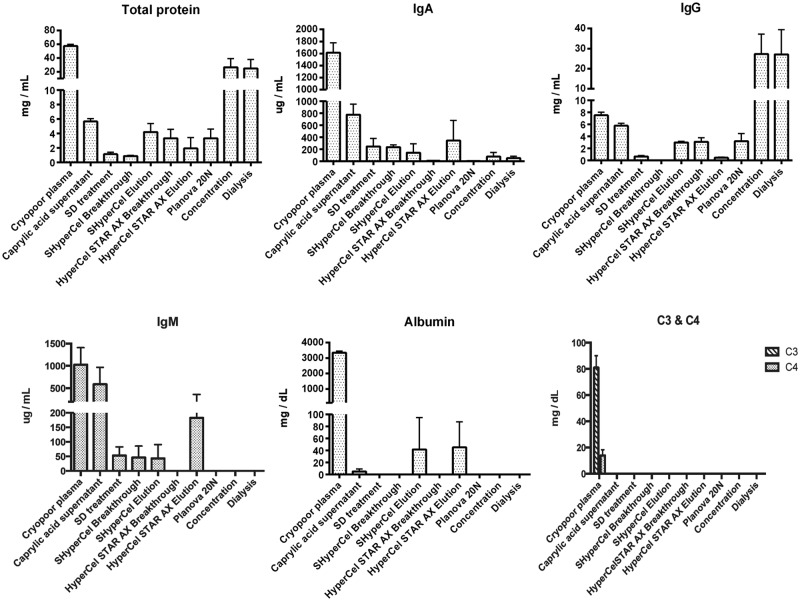
Contents of total proteins, immunoglobulin G (IgG), IgA, IgM, albumin, and complement 3 (C3) and C4 fractions throughout the purification process.